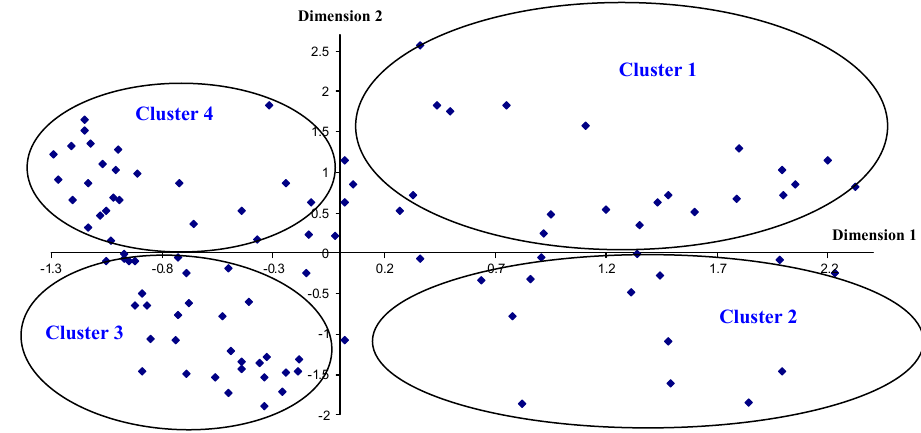
Figure 3. Factorial plane of the object scoring (companies).